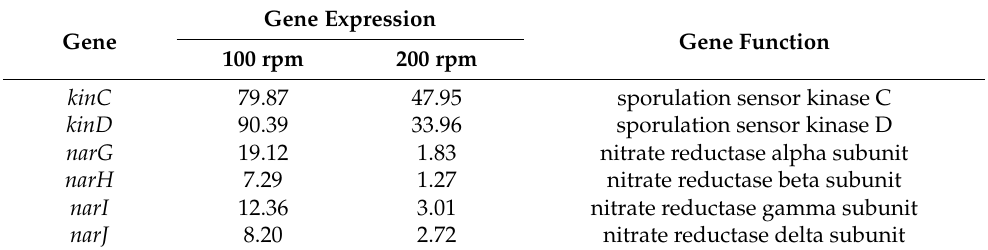
Table 3. The gene expression of nitrogen metabolism in Bacillus velezensis CMT-6 at different dissolved oxygen